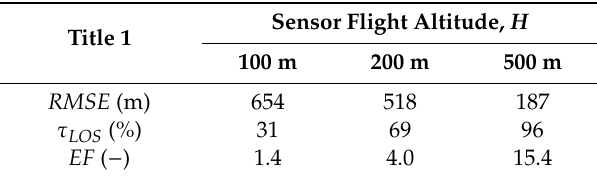
Table 2. Effectiveness metrics for the different flight altitudes.